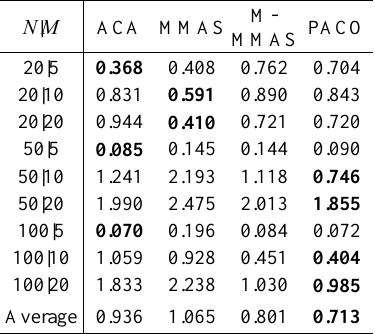
Table 3. Comparison of the ACA with MMAS, M-MMAS and